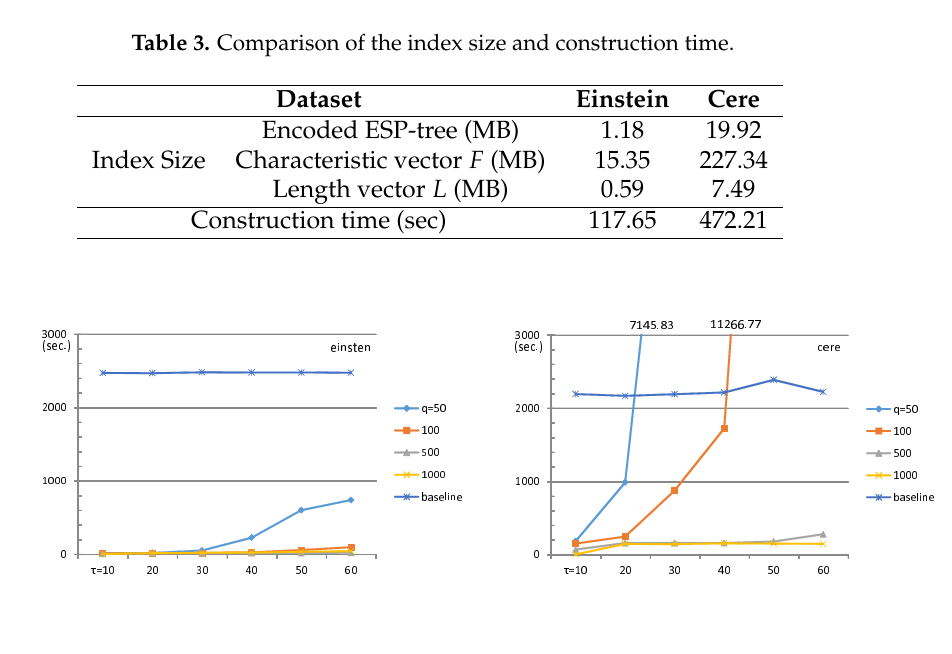
Figure 5. Comparison of the search time for einstein ( left ) and cere ( right